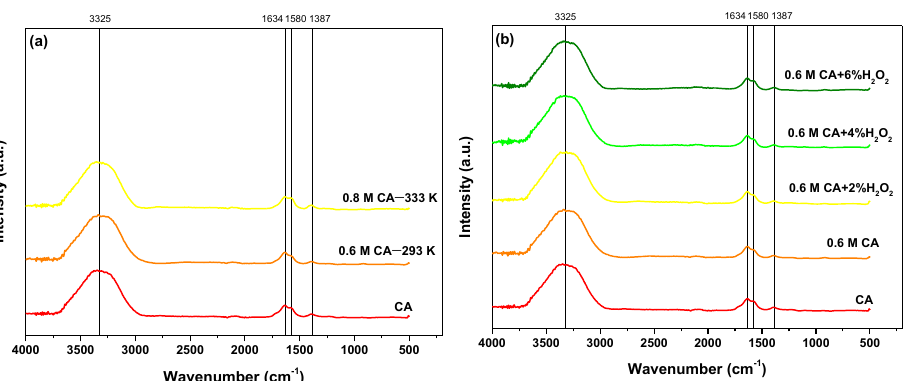
Figure 5. FTIR spectra of PLS solutions obtained using ( a ) 0.6 M CA and ( b ) With the additional amount of H 2 O 2 .